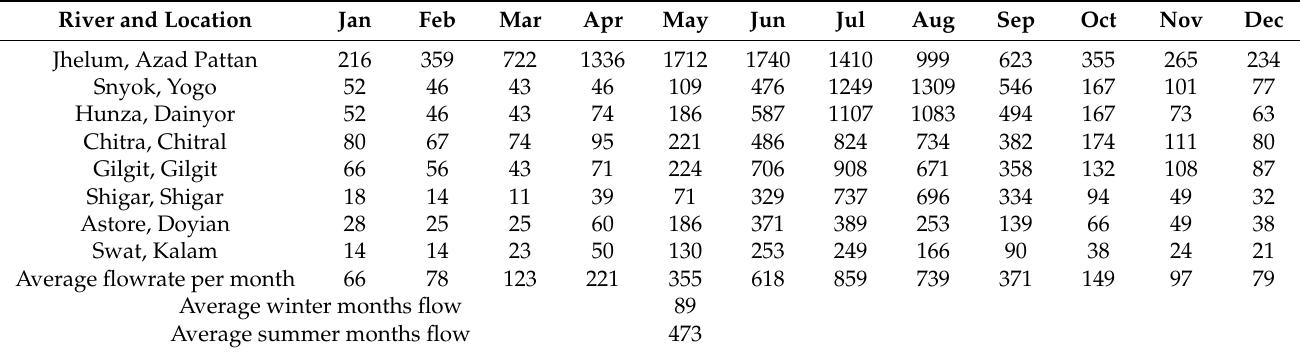
Table 1. Flowrates (m 3 /s) of rivers and streams in the region.